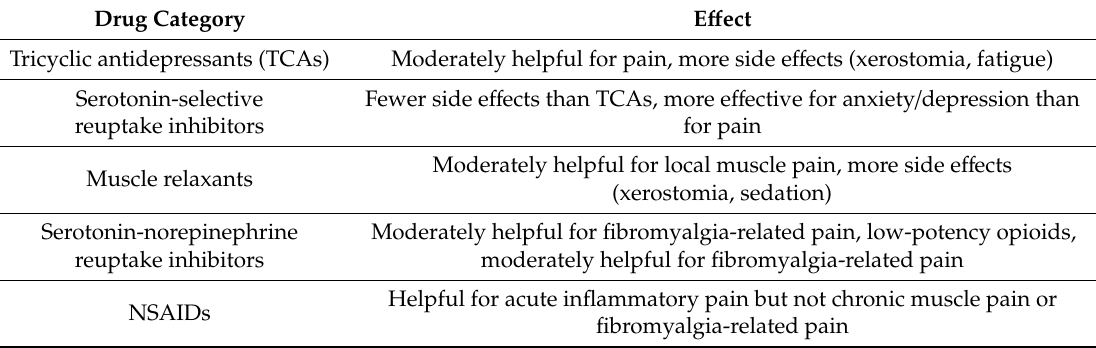
Table 5. Medications used for fibromyalgia that may be beneficial for masticatory muscle pain according to De Rossi et al.